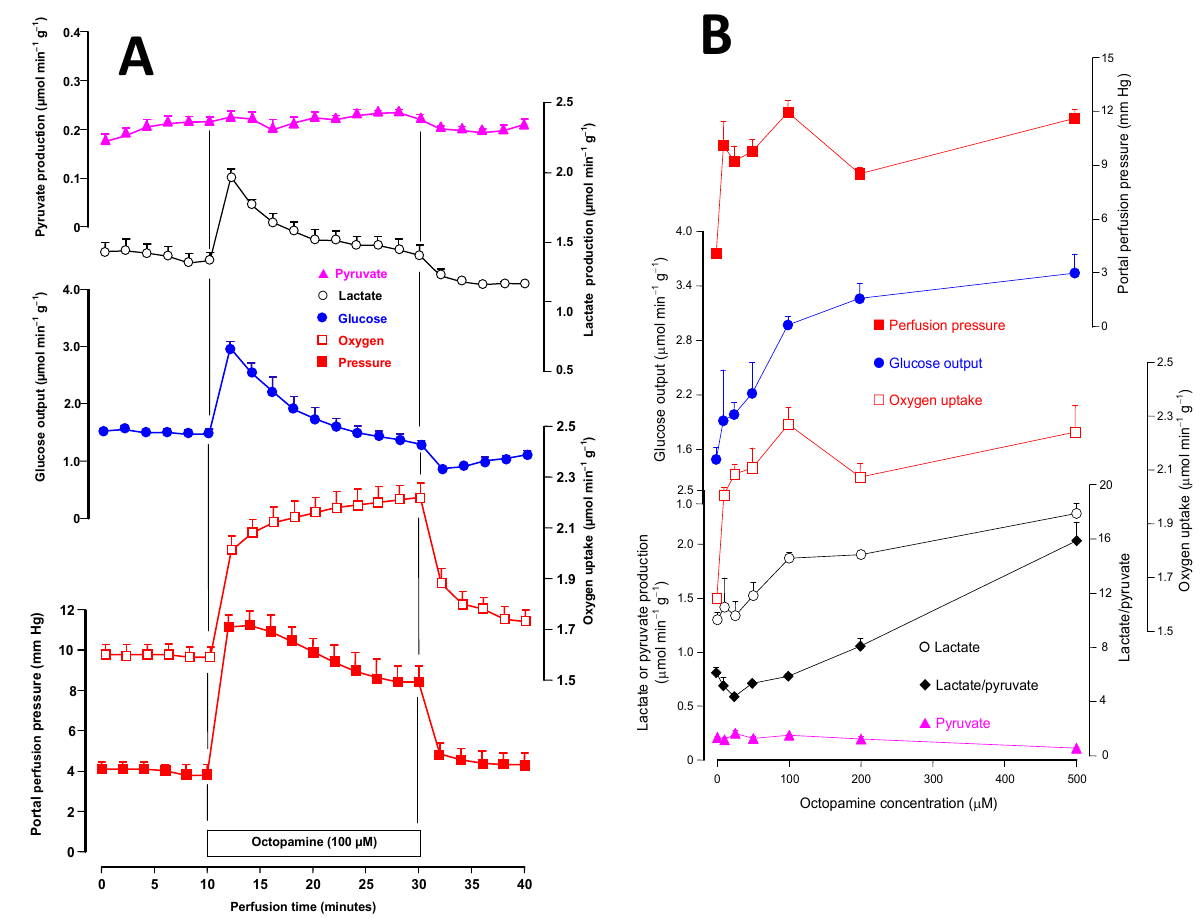
Figure 1. Effects of octopamine on the perfusion pressure, glycogen catabolism and oxygen uptake in the perfused liver of fed rats. Livers were perfused with substrate-free perfusion fluid as described in the experimental section. Panel A illustrates the time courses of the changes caused by 100 μ M octopamine. And Panel B shows the concentration dependences of the changes caused by octopamine between 10 and 500 μ M. Datum points are means ± mean standard errors of 3–4 liver perfusion